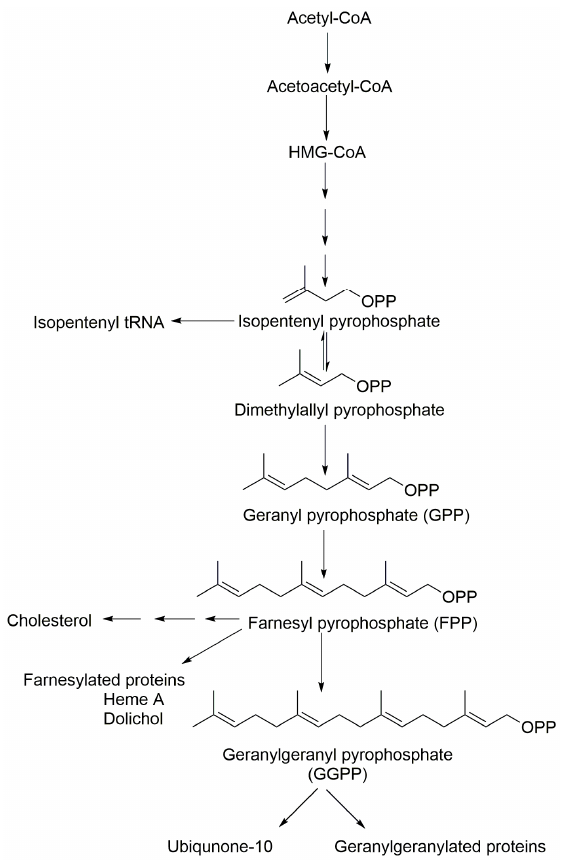
Figure 1. The isoprenoid biosynthetic pathway. Geranyl pyrophosphate (GPP), farnesyl pyrophosphate (FPP), and geranylgeranyl pyrophosphate (GGPP) are key intermediates in the IBP.